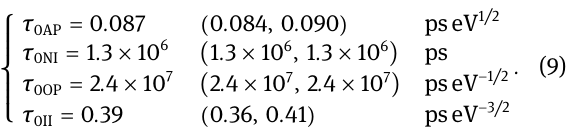
lated using Eqs. (6) and (7) [7].